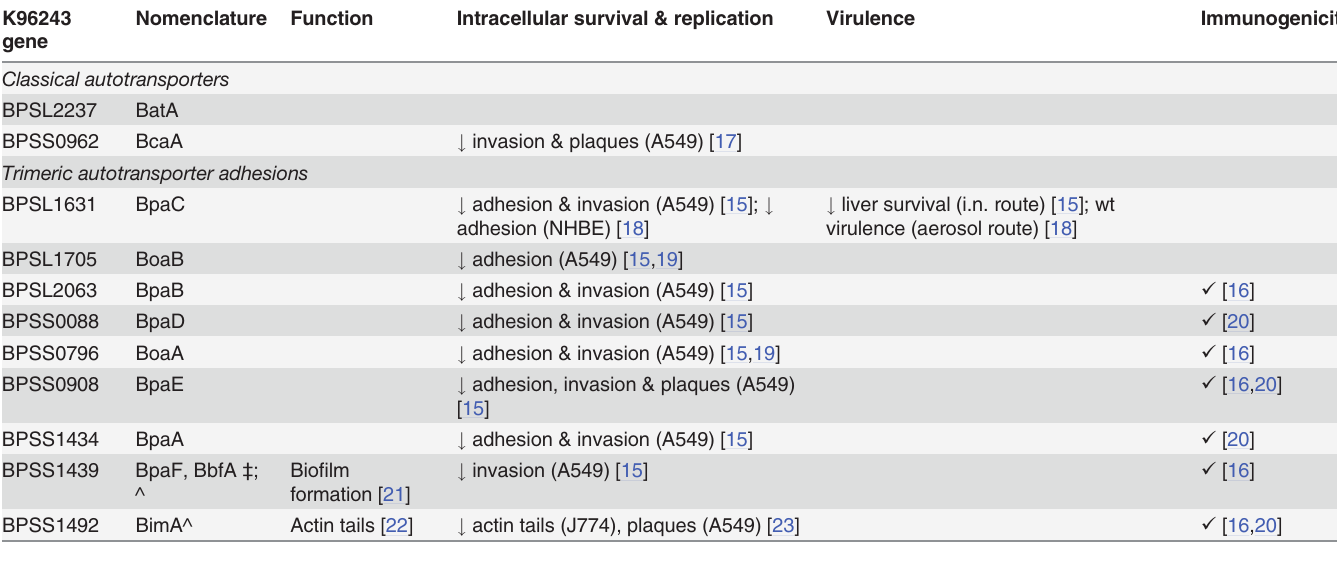
Table 1. Autotransporters of B . pseudomallei and their published